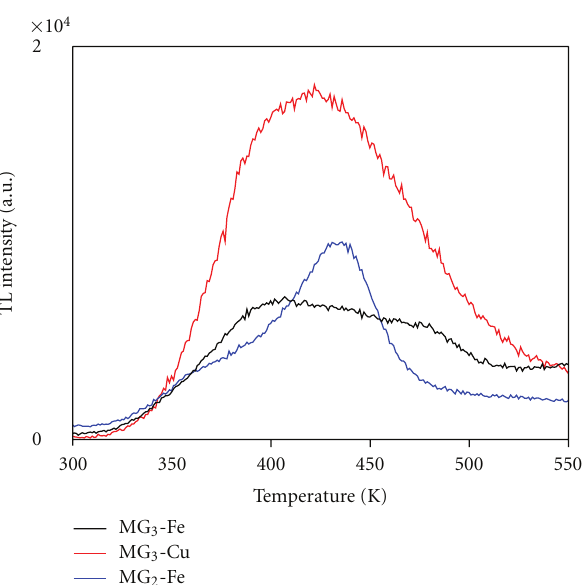
Figure 13: TL glow curves of MG 2 -Fe at di ff erent doses in the interval 100–800 Gy.